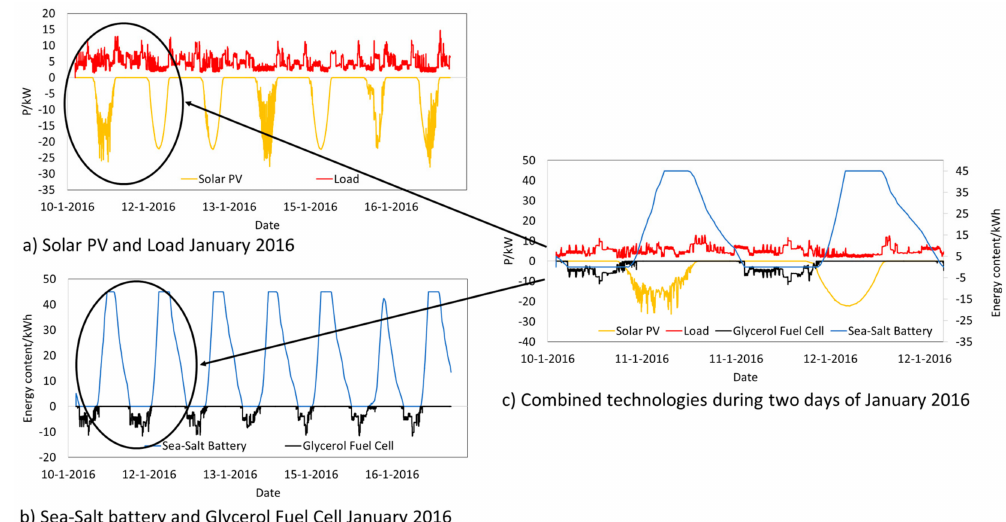
Figure 8. DEMkit results of an o ff -grid house in the Netherlands with Solar PV, sea-salt battery and a glycerol fuel cell during one week of winter 2016 showing ( a ) Solar PV and Load, ( b ) Sea-Salt battery and glycerol fuel cell cell and ( c ) a zoom in on January 11 and 12 2016 with Solar PV, Load, Sea-Salt battery and glycerol fuel